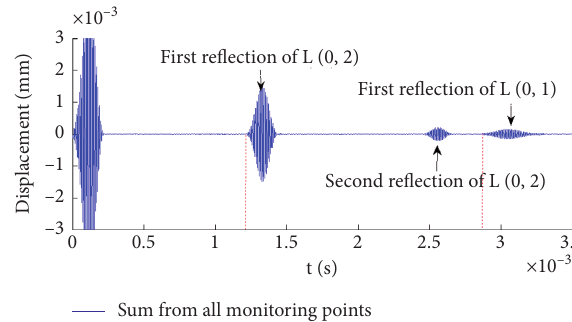
Figure 9: Sum of the time domain waveforms received from all 12 monitoring points.